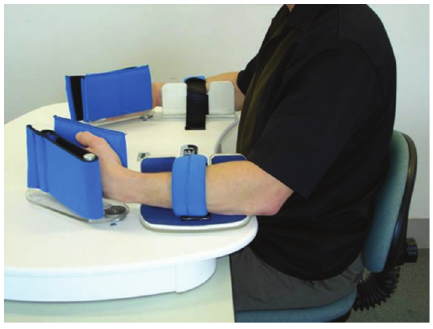
Figure 4: Reha-Slide (Nudelholz). Reprinted with permission (http://www.reha-stim.de/).